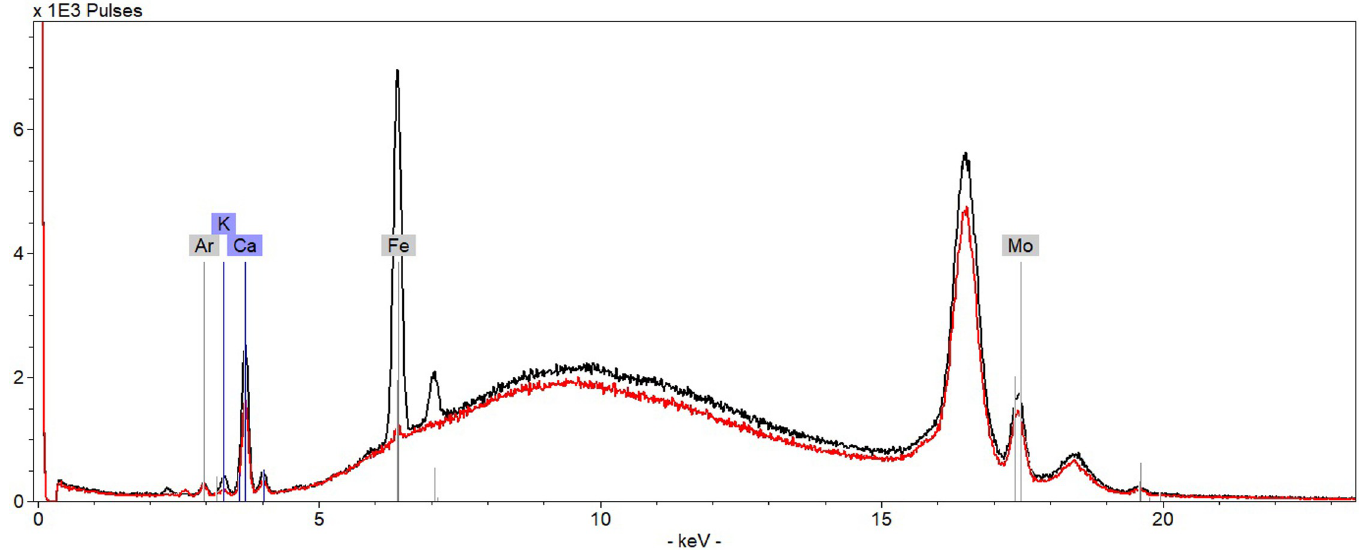
Fig 22. XRF spectra from K403 828. Accumulated spectra (5 points) paper (red spectrum) and Christina’s writing ink line 6 (black spectrum).